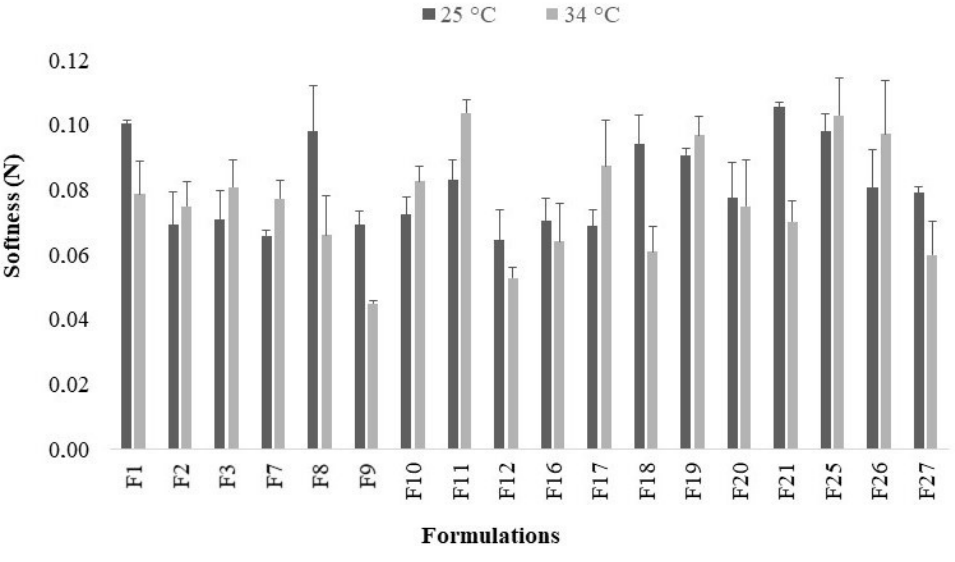
Figure 5. Determination of softness index (N) of the emulsion systems at 25 °C and 34 °C (n = 3). Formulations containing AN oil (at 25 °C) did not demonstrate a significant differ- ence in softness values using the three polymers or the three combinations of bioactive agents ( p < 0.05). However, at 34 °C, as also observed for emulgels containing the PF oil, PC demonstrated significant differences against C934P ( p = 0.000477) and C974P ( p = 0.000936).